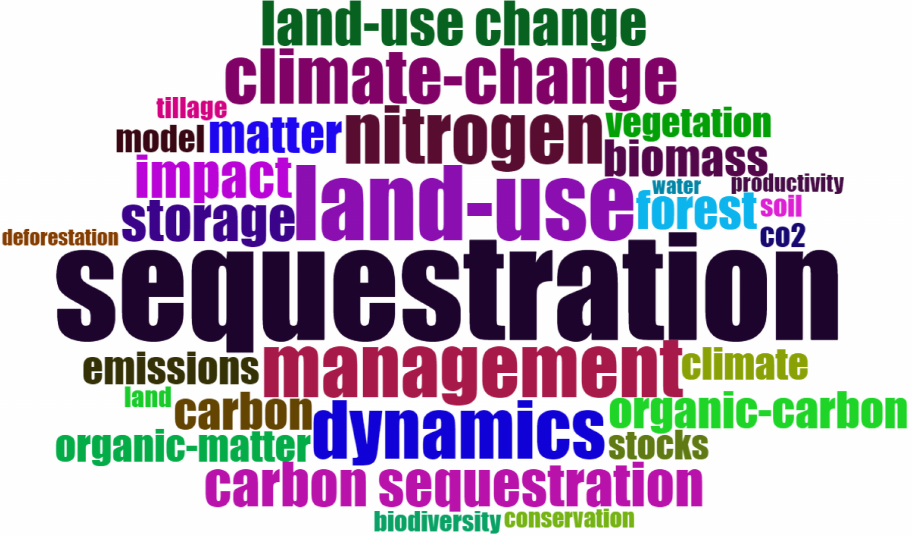
Figure 6. High-Frequency Keywords in the Field of Impacts of Land Use Change on Soil Carbon Sequestration from 1985 to